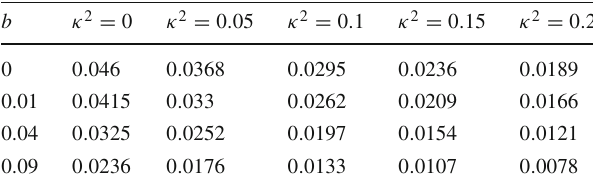
Table 2 Numerical results of T c /μ for different values of κ and